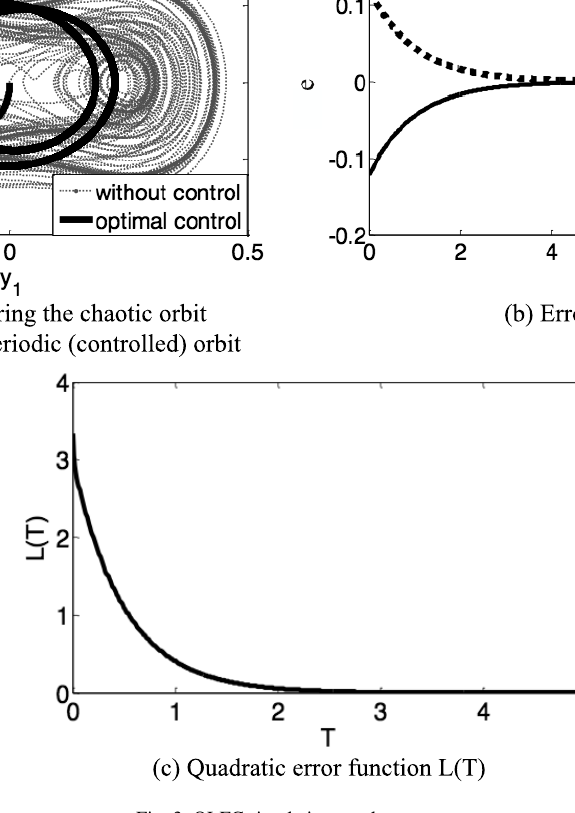
Fig. 3. OLFC simulation